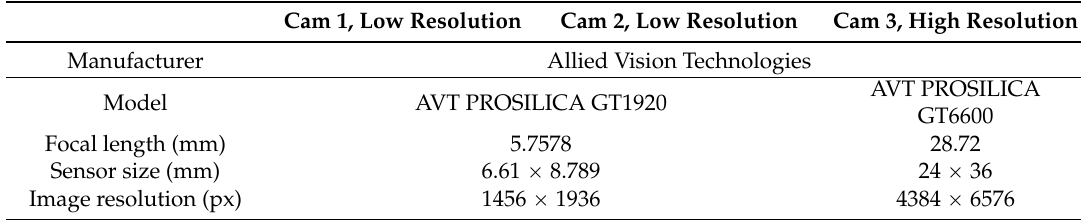
Table 1. Intrinsic parameters for the trifocal system.